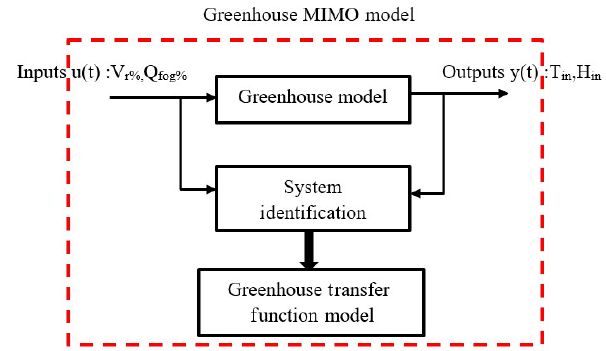
Figure 4. General Block Diagram of System Identification for Greenhouse Model.